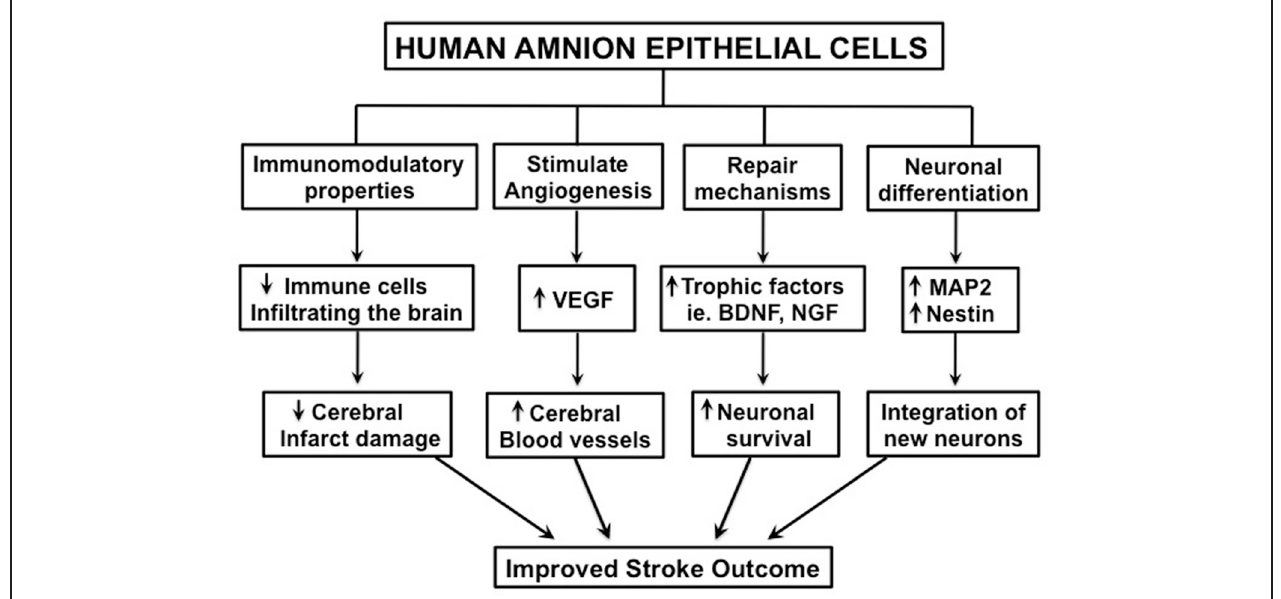
FIGURE 2 | Schematic diagram illustrating the potential mechanisms by which human amnion epithelial cells may improve stroke outcome. “ ↑ ” = increased; “ ↓ ” = decreased.